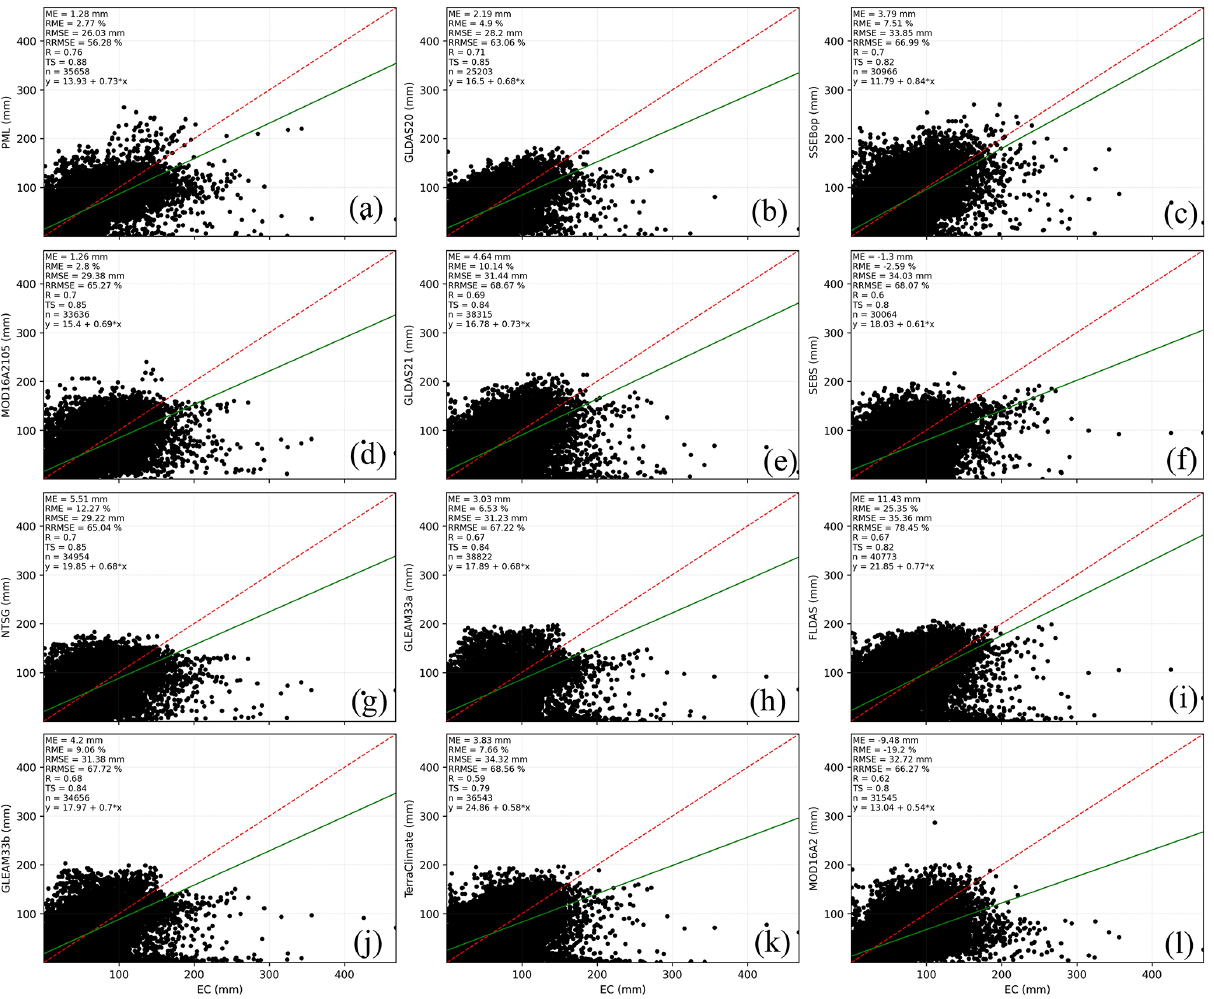
Figure 4. Monthly ET products (PML: a ; GLDAS20: b ; SSEBop: c ; MOD16A2105: d ; GLDAS21: e ; SEBS: f ; NTSG: g ; GLEAM33a: h